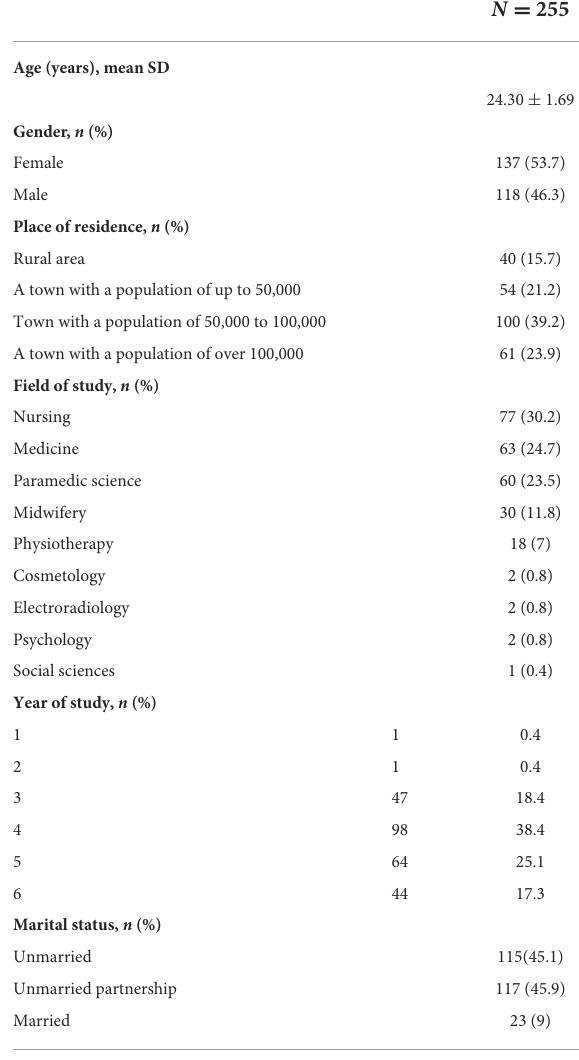
TABLE 1 Socio-demographic characteristics of